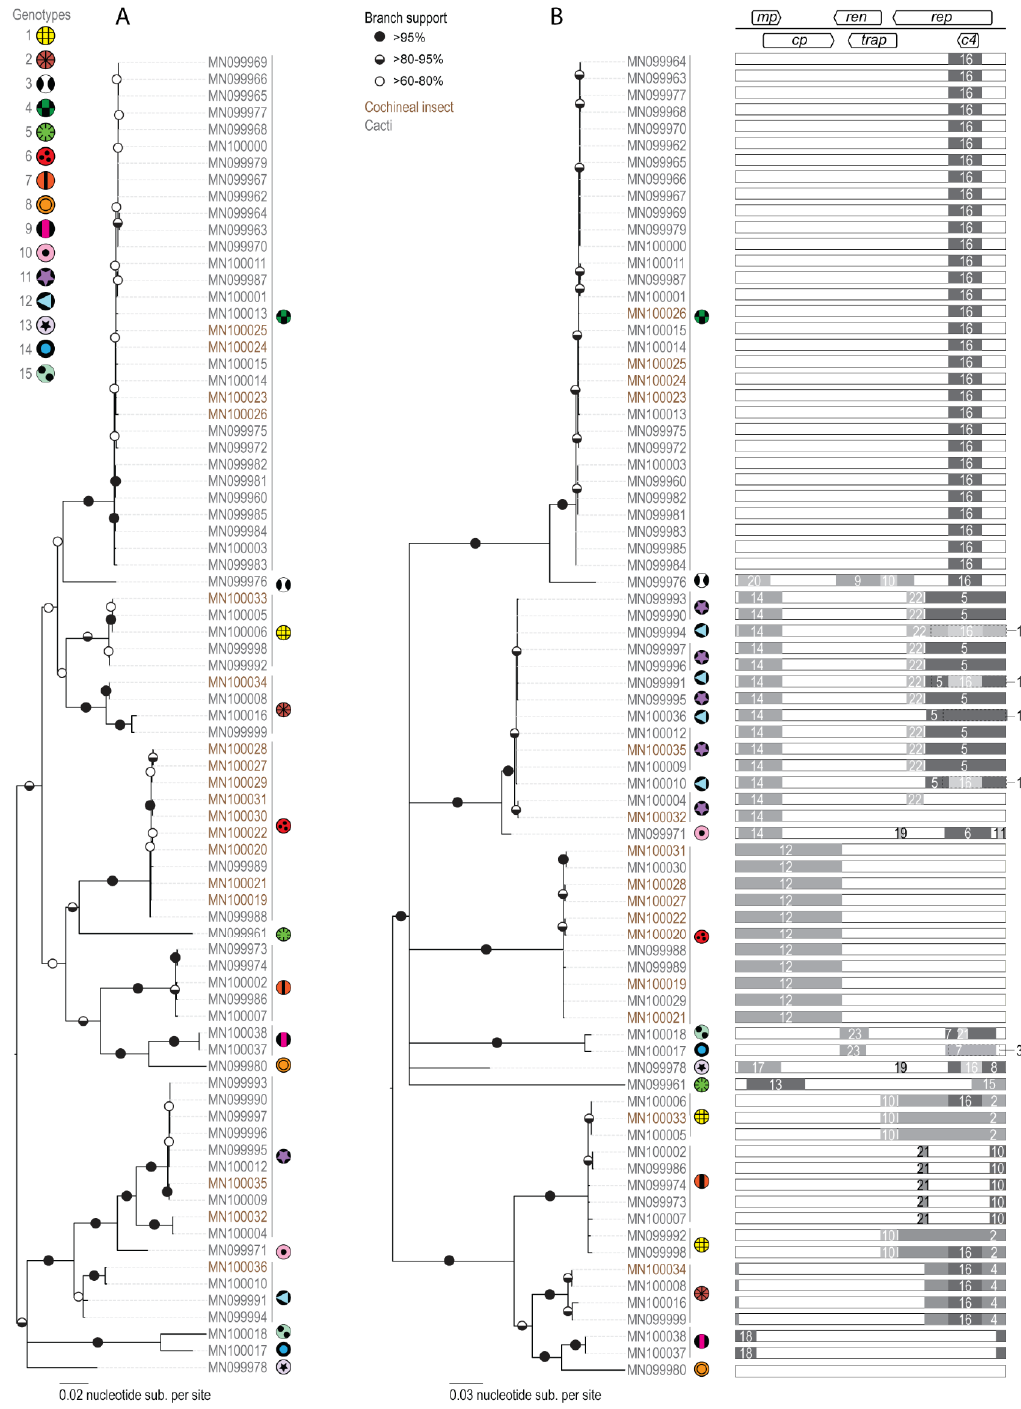
Figure 4. ( A ). Neighbor-Joining phylogenetic tree of the 79 OpV1 genomes recovered in this study. Branches with < 60% bootstrap support are collapsed. ( B ). Maximum Likelihood phylogenetic tree of the 79 OpV1 genomes with recombination regions removed. For each genome, a graphic on the right indicates the recombination event with its breakpoint location within the genome. Branches with < 60% bootstrap support are collapsed. The 15 genotypes are marked with symbols and genomes that have been recovered from plants (accession numbers in grey) and cochineal insects (accession numbers in brown) are